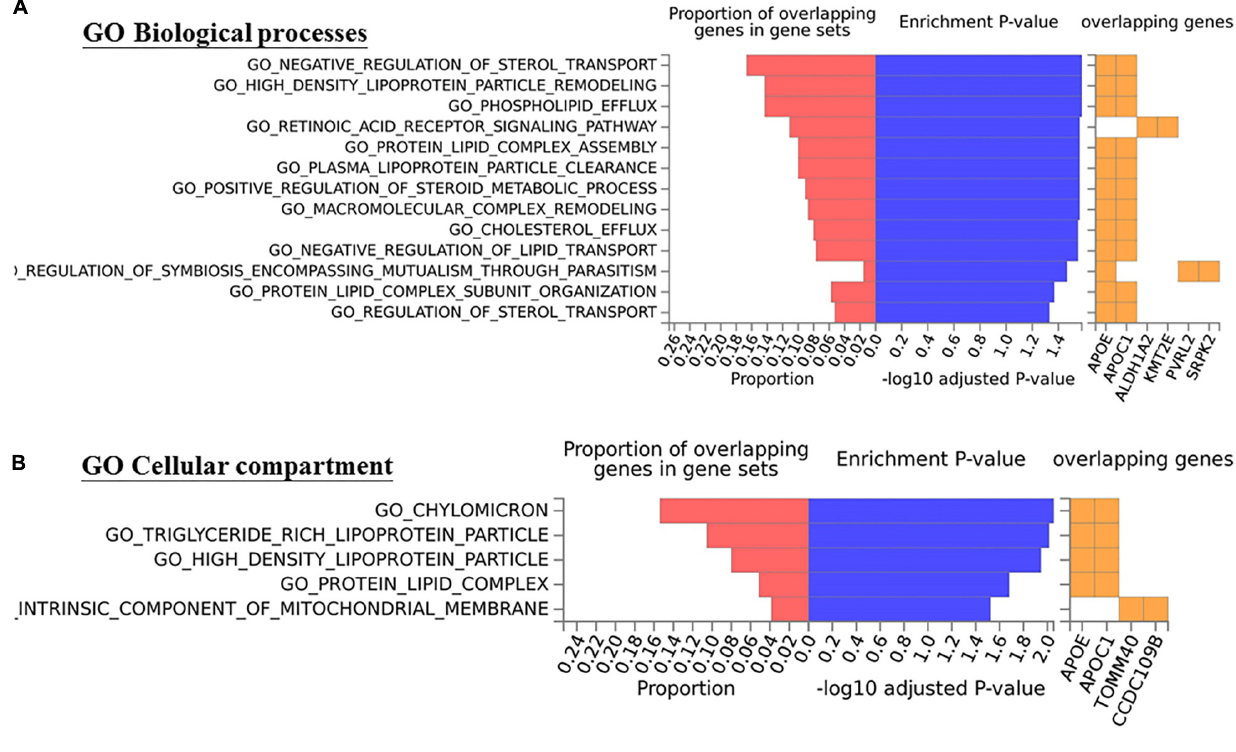
FIGURE 5 | The five SNPs with consistent effects between CSC and AMD show enrichment with Gene Ontology (A) Biological processes and (B) Cellular compartment terms (mainly related in lipid metabolism, B-H adj p <